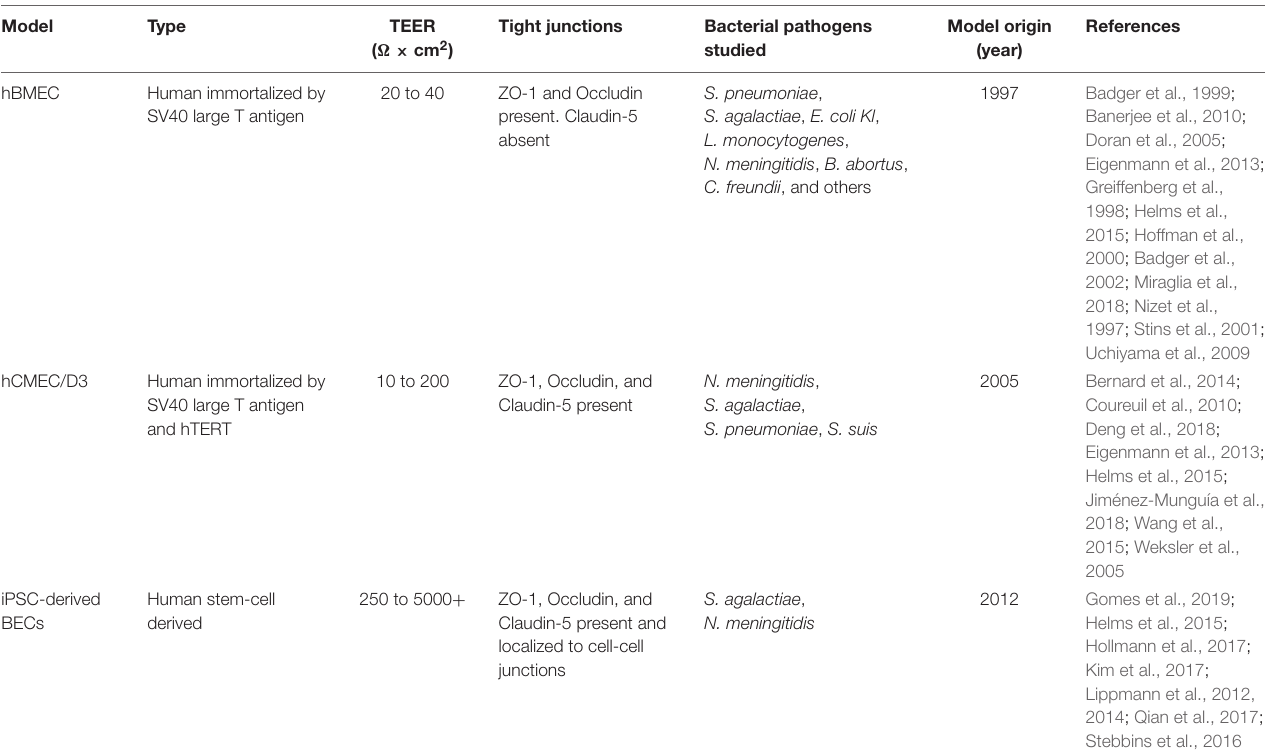
TABLE 1 | Comparison of in vitro BEC